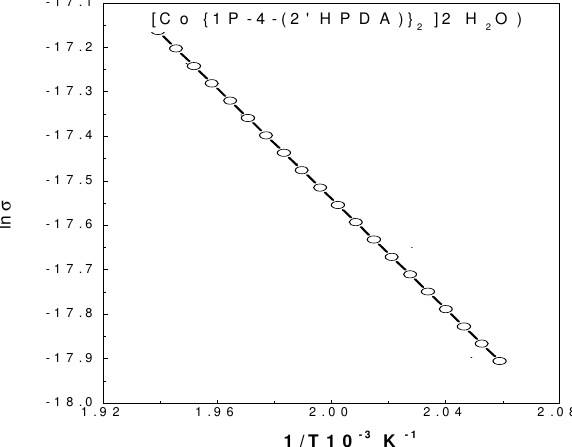
Figure 4. Temperature dependence of electrical